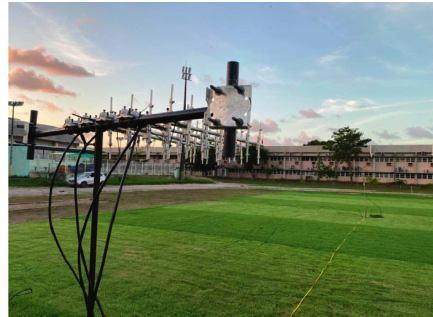
Figure 13: Antenna array.